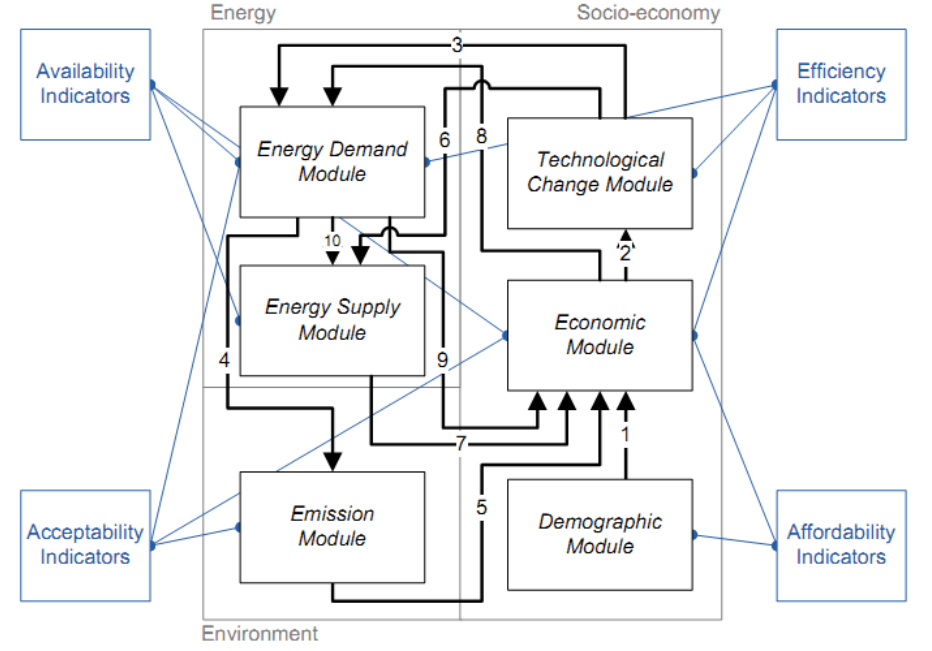
Figure 2. Overview of the model structure: Sectors, Modules, Indicators and Relationships. The blue lines indicate information retrieved when simulating the model. The arrows indicate the key causal relationships between the